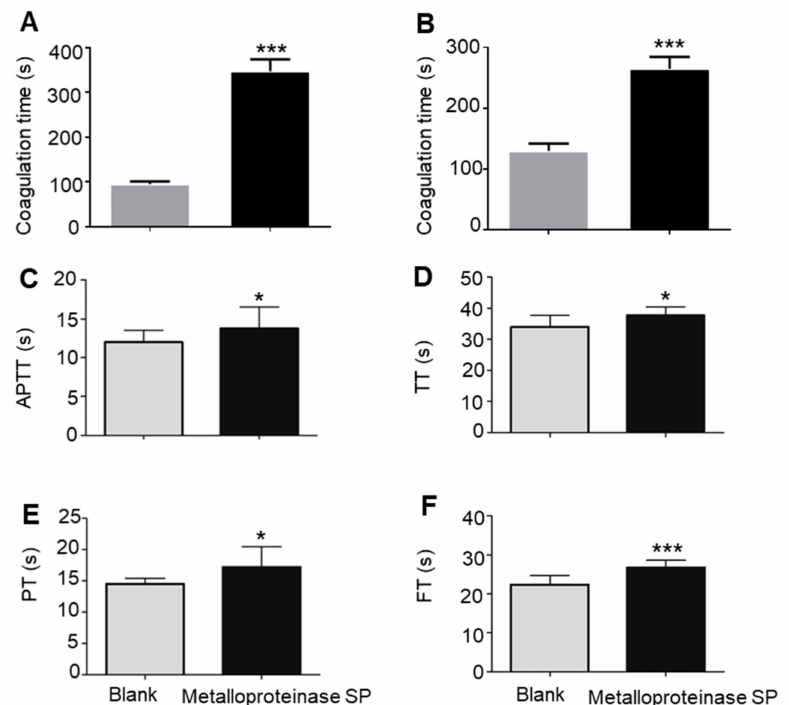
Figure 2. Anticoagulant activity of metalloproteinase SP was evaluated by coagulation time. ( A ) Blood coagulation time was determined by using the capillary technique. ( B ) Blood coagulation time was determined by the slide method. ( C ) Activated partial thromboplastin time (APTT). ( D ) Thrombin